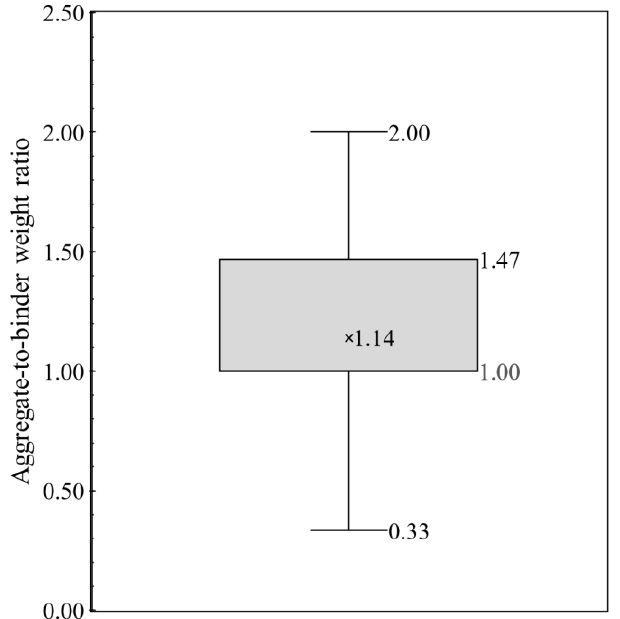
Figure 5. Whiskers box of aggregate-to-binder weight ratio for 157 mixtures design based on literature survey (data source: [30,44–85,89–92]).